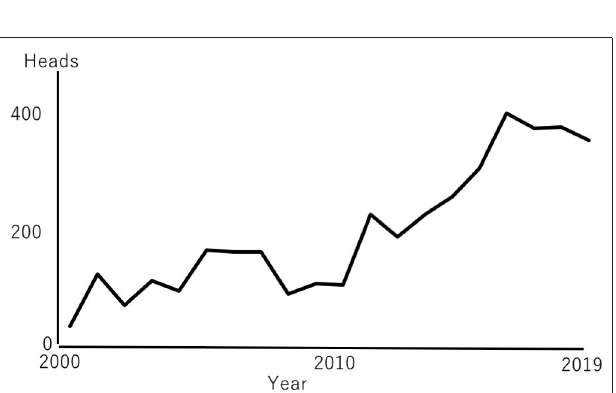
FIGURE 1 | Changes in the number of reported cases of three diseases. Fluctuation of three diseases during 20 years are indicated with different kind of lines, respectively. Plots were based on the reported numbers in MAFF (1, 2). BVD, bovine viral diarrhea; EBL, enzootic bovine leukemia; JD, Johne’s disease.